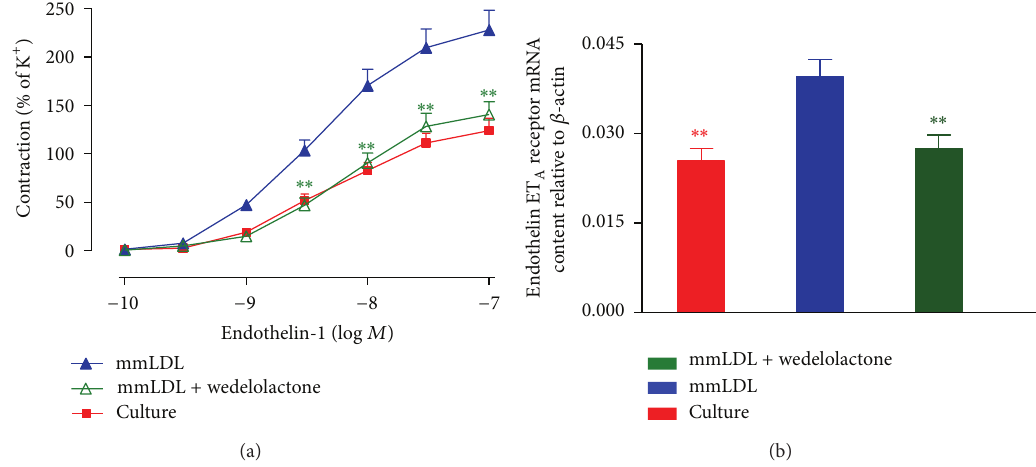
Figure 5: Effect of the NF- 𝜅 B pathway inhibitor on the mmLDL-induced upregulation of ET A receptors in the coronary artery. Rat coronary artery segments were cultured with mmLDL (10 𝜇 g/mL) in the presence of the NF- 𝜅 B inhibitor wedelolactone (10 𝜇 M) for 24 h. The concentration-contraction curves mediated by the ET A receptor ((a) 𝑛 = 8 coronary arteries, the number of animals) and the levels of ET A receptor mRNA ((b) 𝑛 = 6 coronary arteries, from that number of animals) are shown. The data are presented as the mean ± SEM. ∗∗ 𝑃 < 0.01 versus